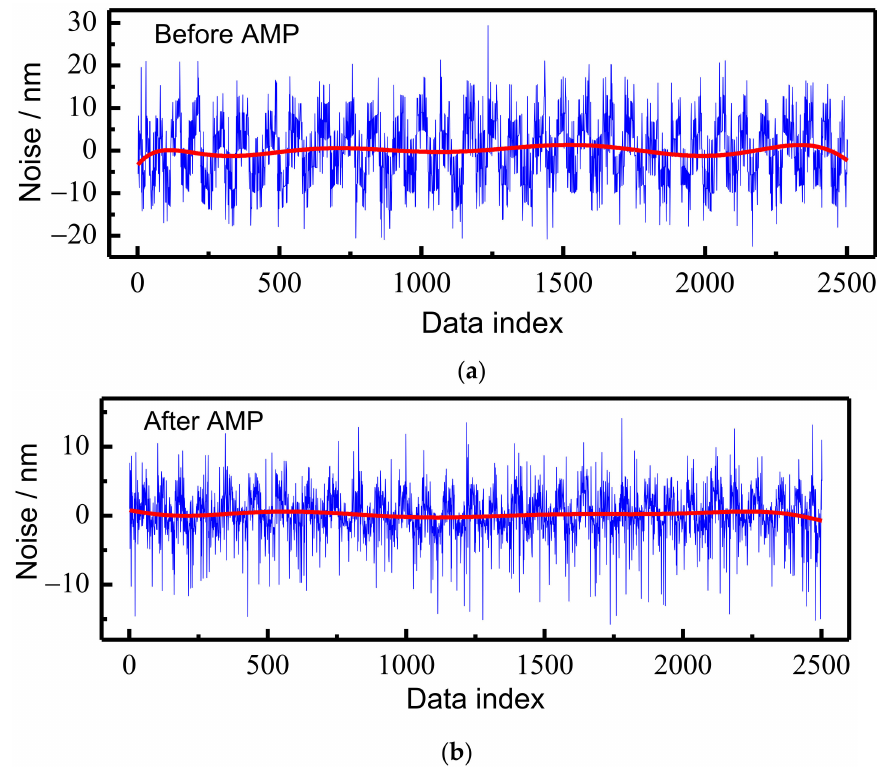
Figure 7. Noise test: ( a ) Before amplification; ( b ) After